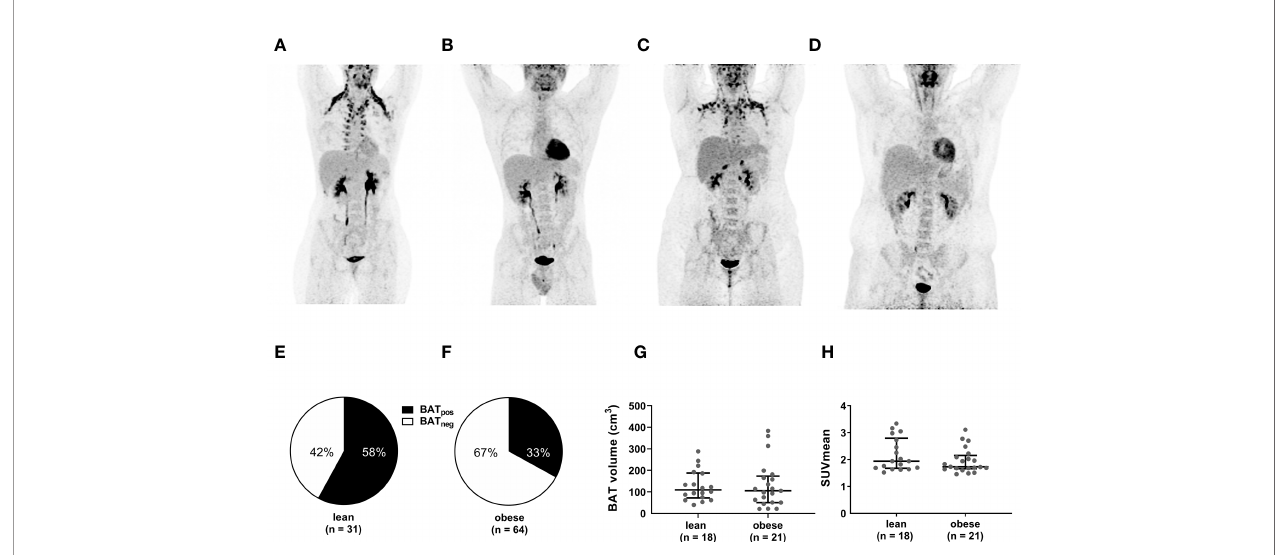
FIGURE 1 | Lower frequency of active BAT but similar BAT volume and activity in obese versus individuals. Representative PET images of lean BAT pos (A) and BAT neg (B) as well as obese BAT pos (C) and BAT neg (D) participants. Compared to BAT neg individuals, BAT pos individuals exhibit signi fi cant 18 F-FDG uptake in the deep cervical, supraclavicular, axillar, and paravetrebral fat depots. The pie charts depict the proportion of BAT pos to BAT neg participants in the lean (E) and the obese (F) cohort. BAT volume (G) and SUVmean (H) in lean and obese individuals with active BAT. The graphs indicate median values and interquartile ranges.